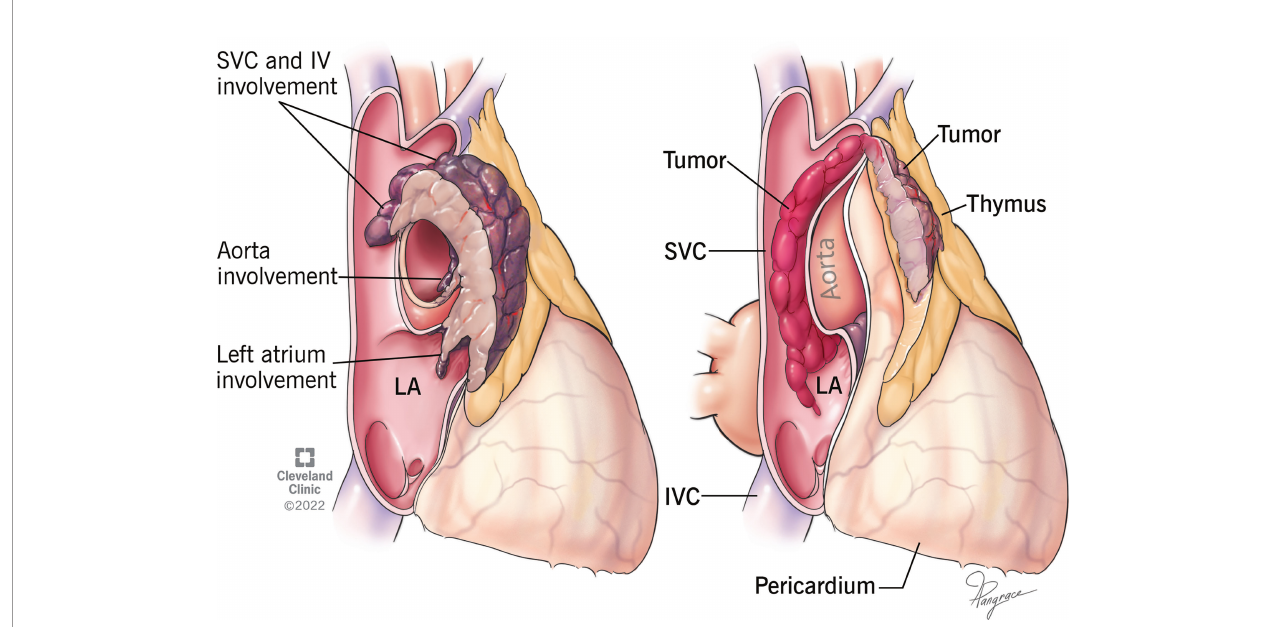
FIGURE 1 | Drawing of 2 different types of vascular invasion. Left: Thymoma invades superior vena cava (SVC), innominate vein (IV), aorta, and left atrium (LA) by contiguous in fi ltration. Right: Thymoma shows a single point of wall invasion into the vessel with intravascular downstream extension into SVC and LA without contiguous